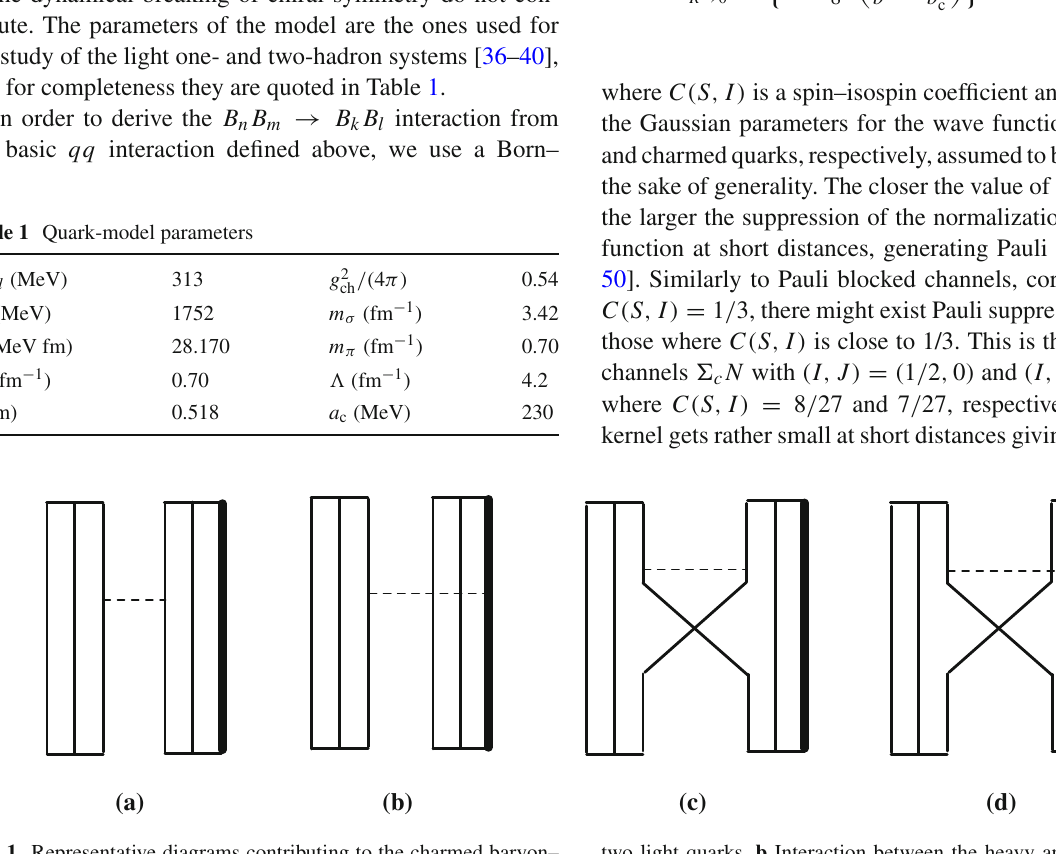
two light quarks. b Interaction between the heavy and a light quark. c Interaction between two light quarks together with the exchange of identical light quarks. d Interaction between the heavy and a light quark together with the exchange of identical light